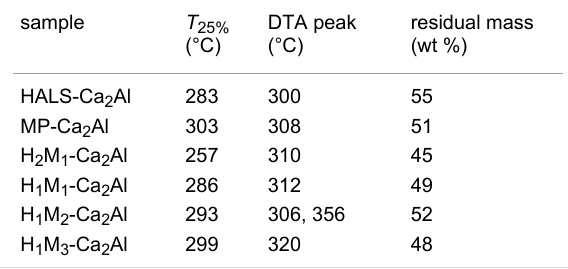
Table 1: TG/DTA results of H n M n ′ -Ca 2 Al-LDH